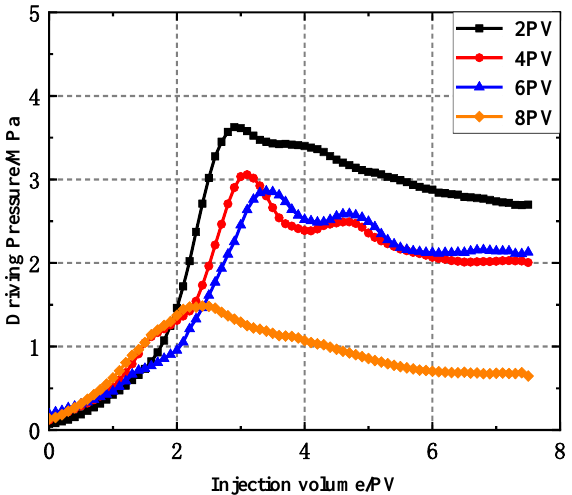
Figure 14. Relationship between the gas injection rate and the water injection rate during water injection.